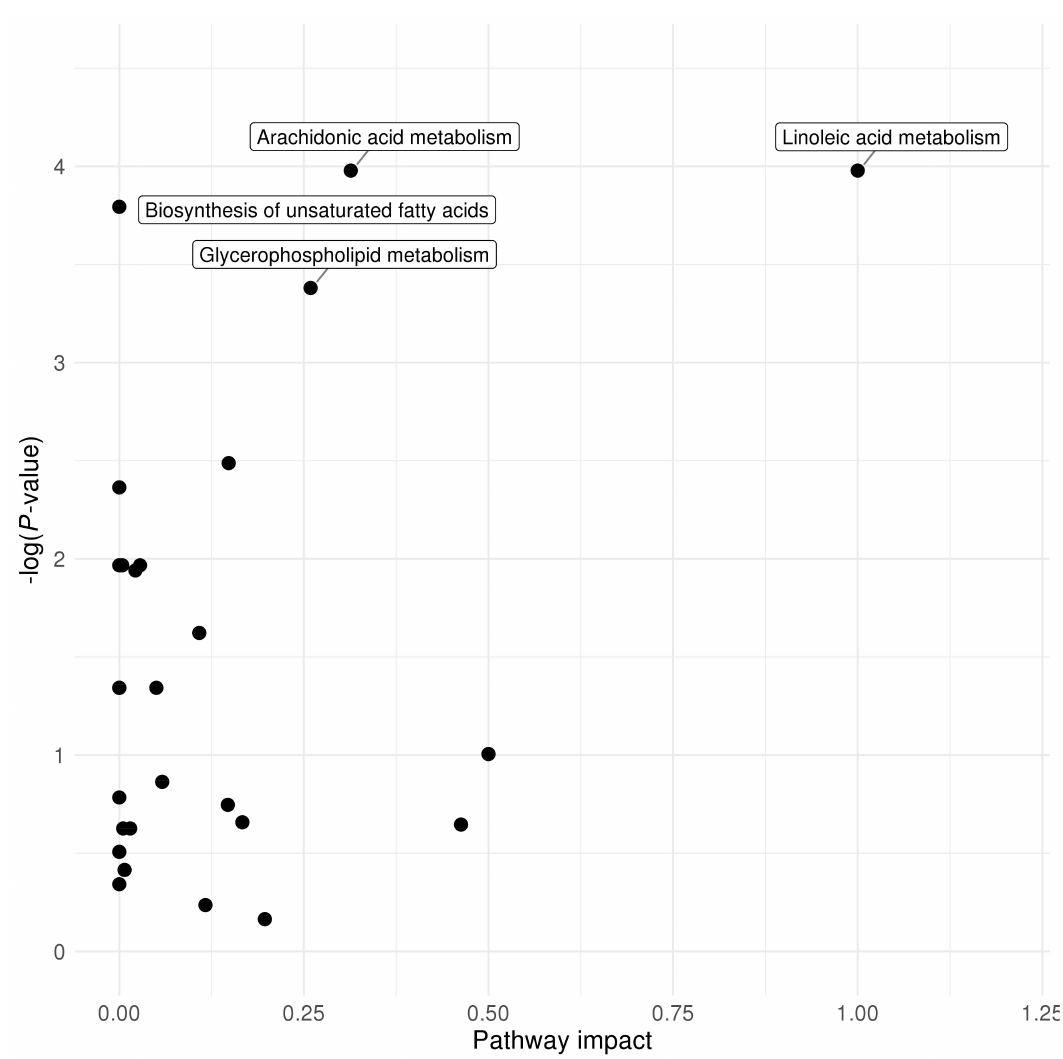
Figure 2. Pathway over-representation analysis significance against pathway impact plot for MetaboAnalyst pathway analysis results at age 3 (natural logarithm of P -value on